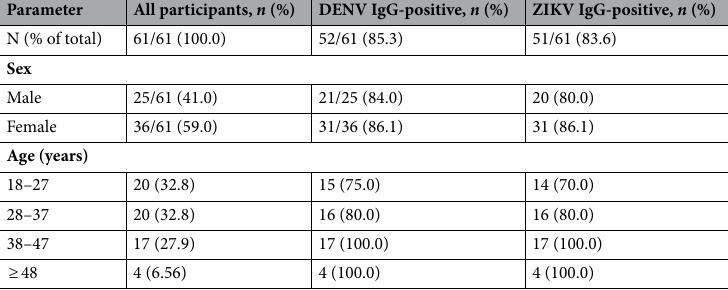
Table 1. The group consisted of 25 men and 36 women with a median age of 31 years (SD 9.9, range 18–69 years). Fifty-two subjects (85.3%) were seropositive for DENV IgG, indicating that most participants had been infected with DENV at least once (Fig. 1A and Table 1). A breakdown of DENV seroprevalence indicated a positive association between prior exposure to DENV and age. Thus, 100% of participants aged 38 years and older were